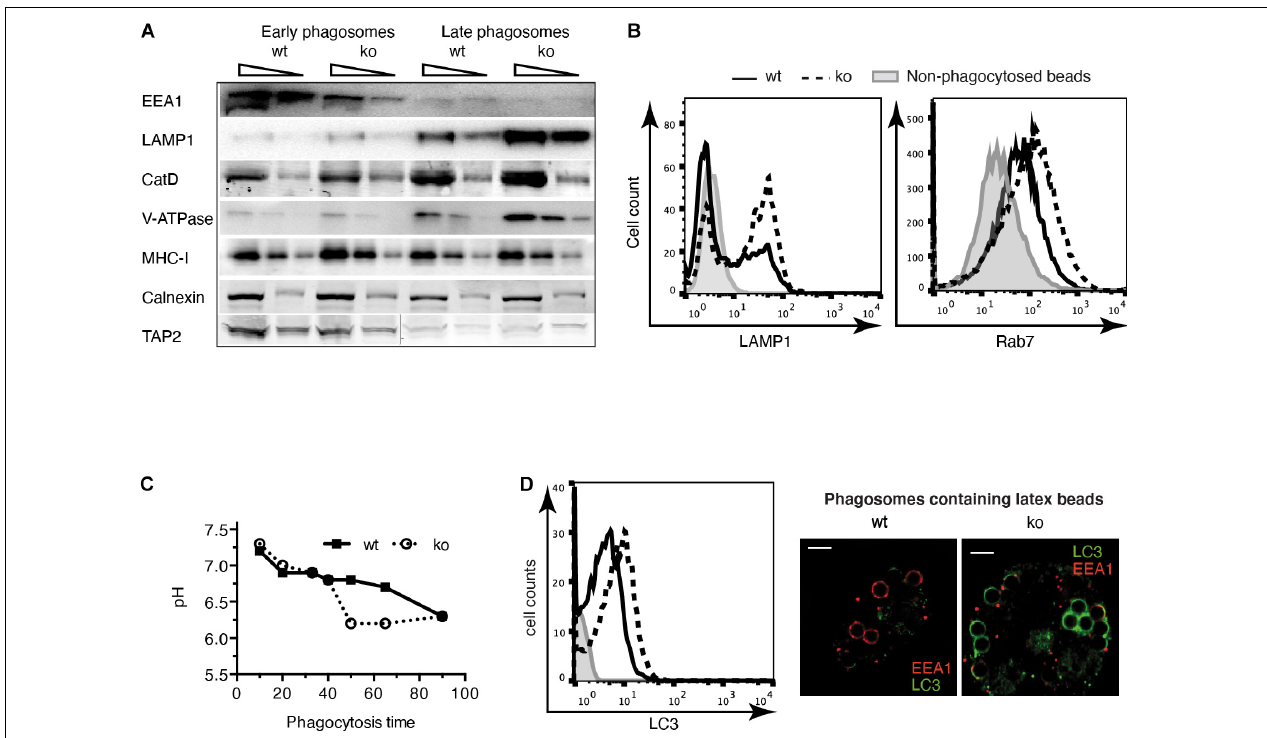
FIGURE 1 | Phagosome maturation is accelerated in insulin-regulated aminopeptidase (IRAP) - / - dendritic cells (DCs). (A) Latex bead phagosomes were isolated from wild-type (wt) or IRAP - / - bone marrow-derived DCs (BM-DCs) by sucrose gradients after a 20-min pulse (early) and after 120 min of chase (late). Equal protein amounts were analyzed by immunoblot for the markers indicated. One of three or more experiments. CatD, cathepsin D. (B) BM-DCs were pulsed for 20 min with latex beads and mechanically disrupted. Phagosomes in the post-nuclear supernatant were fixed, identified with the lipid marker CellmaskTM, stained for lysosome-associated membrane protein (LAMP)1 and Rab7, and analyzed by flow cytometry. One out of 10 (LAMP1) and three (Rab7) experiments. (C) The fluorescence intensity of phagocytosed latex beads conjugated to the pH-sensitive dye carboxyfluorescein succinimidyl ester (CFSE) and the pH-insensitive dye AF647 was monitored over time by flow cytometry. The ratio of CFSE to AF647 fluorescence was converted to pH values using a standard curve of beads in solutions of known pH. One of three similar experiments. (D) BM-DCs were pulsed for 20 min with latex beads, and LC3 staining of phagosomes containing single beads was performed as described in panel (B) . The images to the right show BM-DCs pulsed for 5 min with latex beads, chased for 15 min, and stained for LC3 and EEA1.